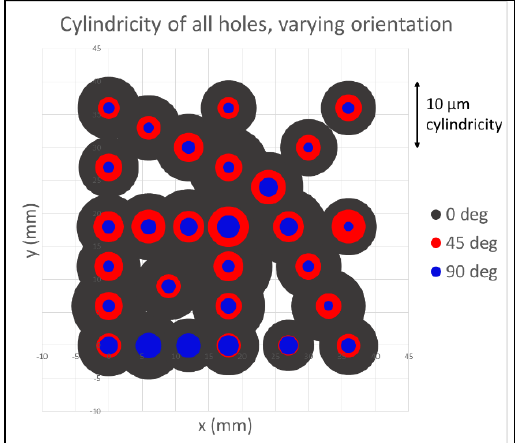
Figure 15: Cylindricity of cylinders compared to CMM data with varying orientation. (Width of circle proportional to